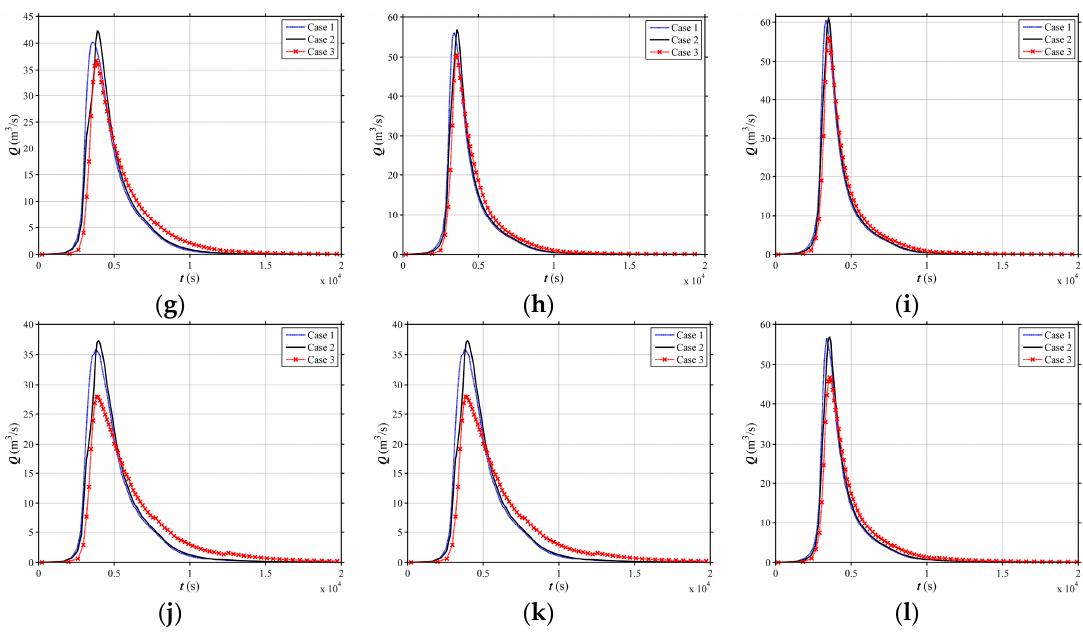
Figure 11. Simulated hydrographs at the outlet for different land use scenarios under the 100-year rainfall event. ( a ) i 1 = 0.01, i 2 = 0.18; ( b ) i 1 = 0.01, i 2 = 0.58; ( c ) i 1 = 0.01, i 2 = 1.19; ( d ) i 1 = 0.02, i 2 = 0.18; ( e ) i 1 = 0.02, i 2 = 0.58; ( f ) i 1 = 0.02, i 2 = 1.19; ( g ) i 1 = 0.05, i 2 = 0.18; ( h ) i 1 = 0.05, i 2 = 0.58; ( i ) i 1 = 0.05, i 2 = 1.19; ( j ) i 1 = 0.08, i 2 = 0.18; ( k ) i 1 = 0.08, i 2 = 0.58; ( l ) i 1 = 0.08, i 2 = 1.19.